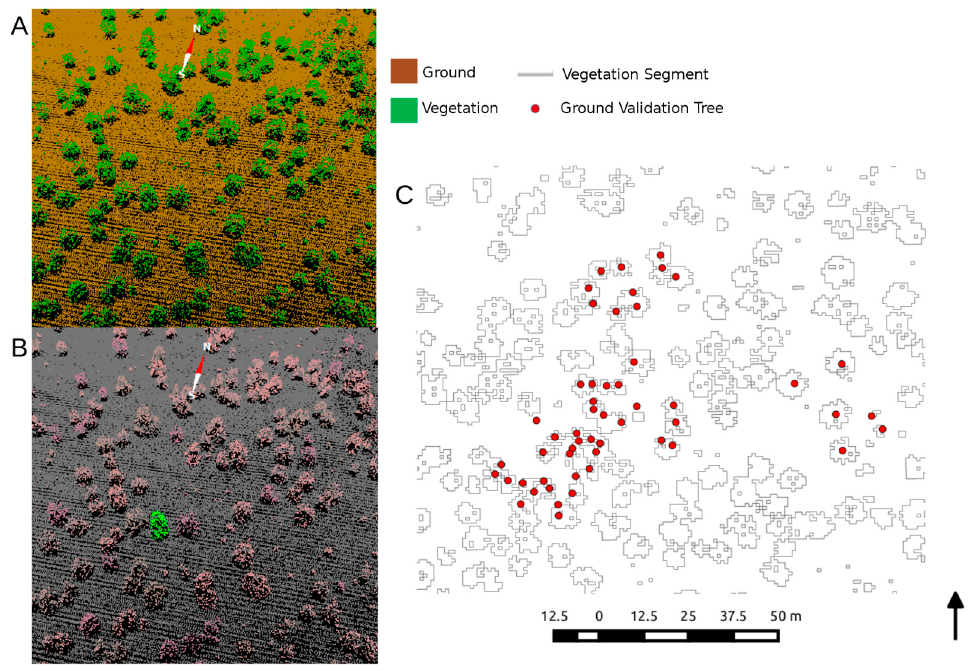
Figure 4. ( A ) The automatic delineation of ground and vegetation from the TEXAS model, resulting in ( B ) clumped crown segmentation, which was then ( C ) vectorized and overlaid on ground-measured stem maps within our study area for segment statistic generation.